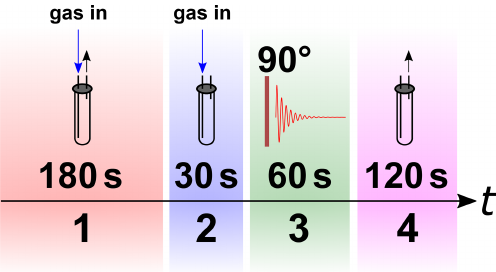
Figure 5. Scheme of the 1 H magnetic field cycling SABRE experi- ment. Stage 1 : shuttling of the sample to the polarization coil. Stage 2: relaxation of the sample at earth’s magnetic field for t w = 10s. Stage 3 : switching on the electromagnet with a magnetic field B p = 6mT and starting bubbling with p H 2 -enriched gas at pres- sure P = 6 . 9 bar or 2.8 bar for t b = 30s. Stage 4 : shuttling of the sample to the bore of the NMR spectrometer in 0.2s and turning off the electromagnet. Stage 5: after 90 ◦ excitation, acquiring the 1 H-NMR spectrum.